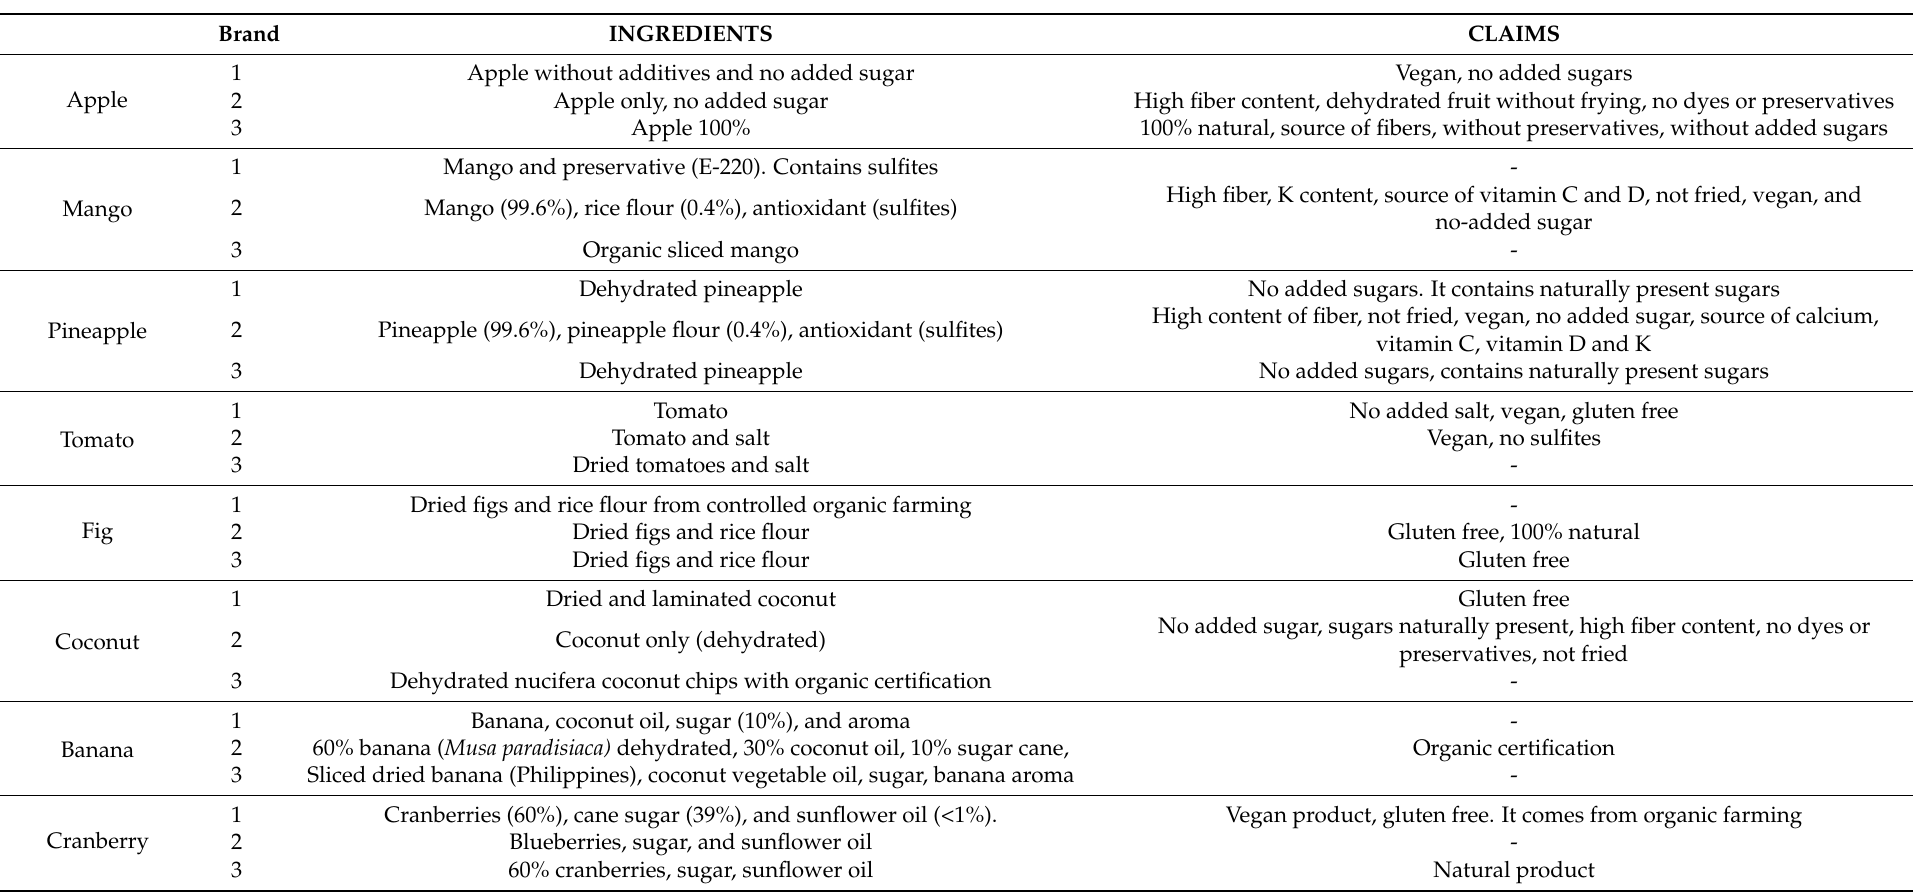
Table 1. Ingredient lists and claims in commercial dried